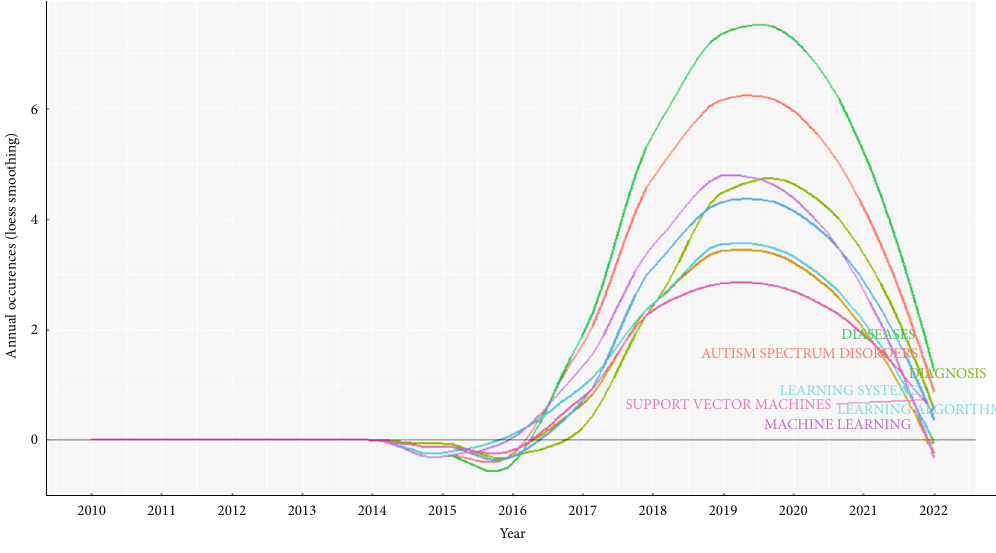
Figure 5: Describe word growth.